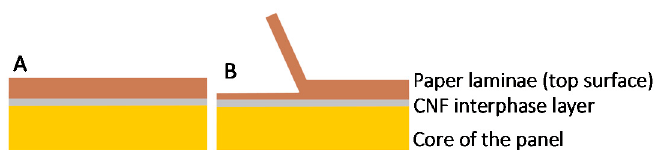
Figure 5. Schematic representation of ( A ) the assembly of the core, interphase and top surface of the paper laminae, and ( B ) mode of failure occurring within the paper laminae.